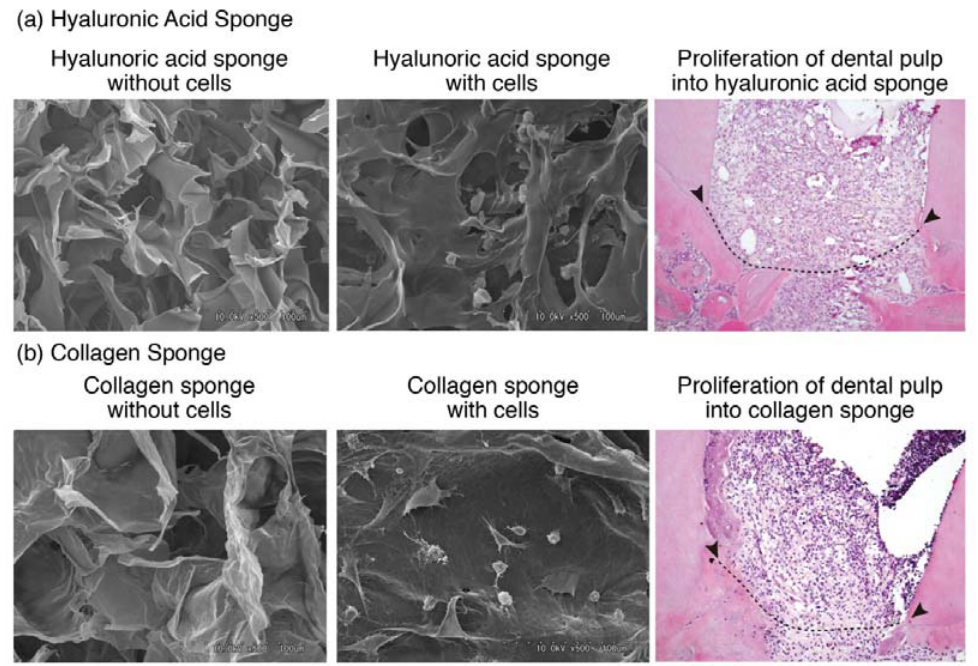
Figure 8. ( a ) Effects of hyaluronic acid sponge on KN-3 cells and amputated dental pulp; ( b ) Effects of collagen sponge on KN-3 cells and amputated dental pulp. Arrowheads and dotted line; amputated line of dental